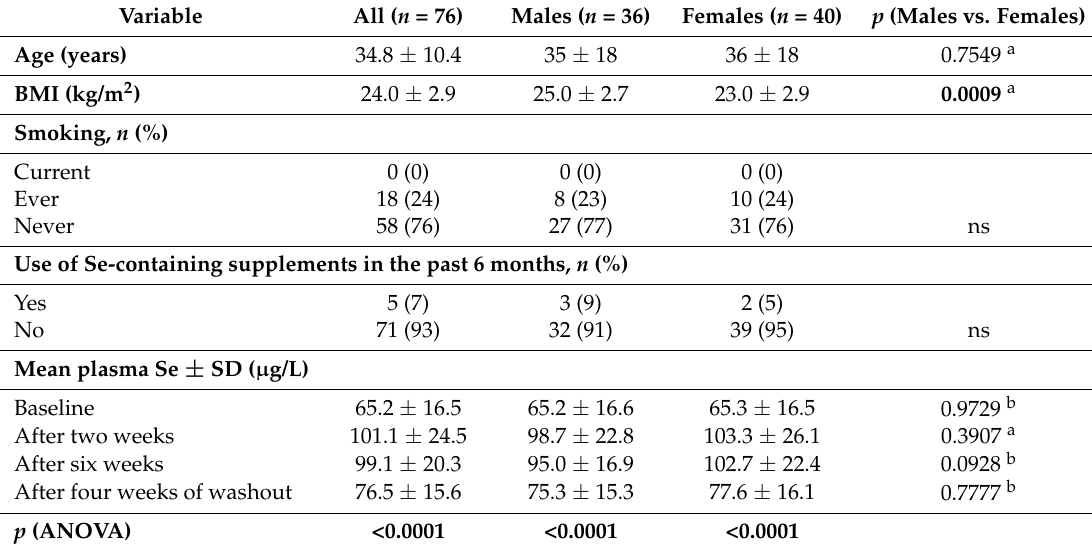
Table 1. Basic characteristics of the study group (76 subjects supplemented with